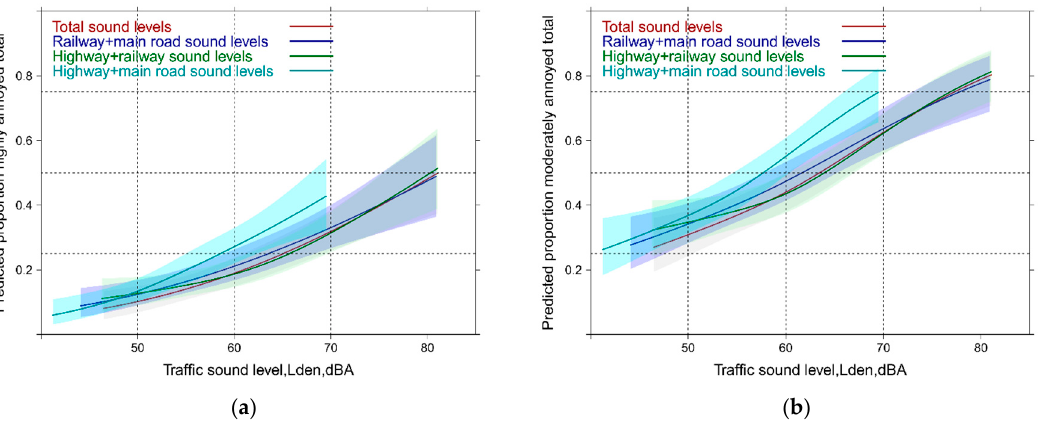
Figure 6. Predicted proportion of total annoyance associated with sound from mixed sources. ( a ) HA = Proportion highly annoyed; ( b ) MA = Proportion moderately annoyed. Adjusted for age, sex, education, noise sensitivity, health status and the other mixed sources.